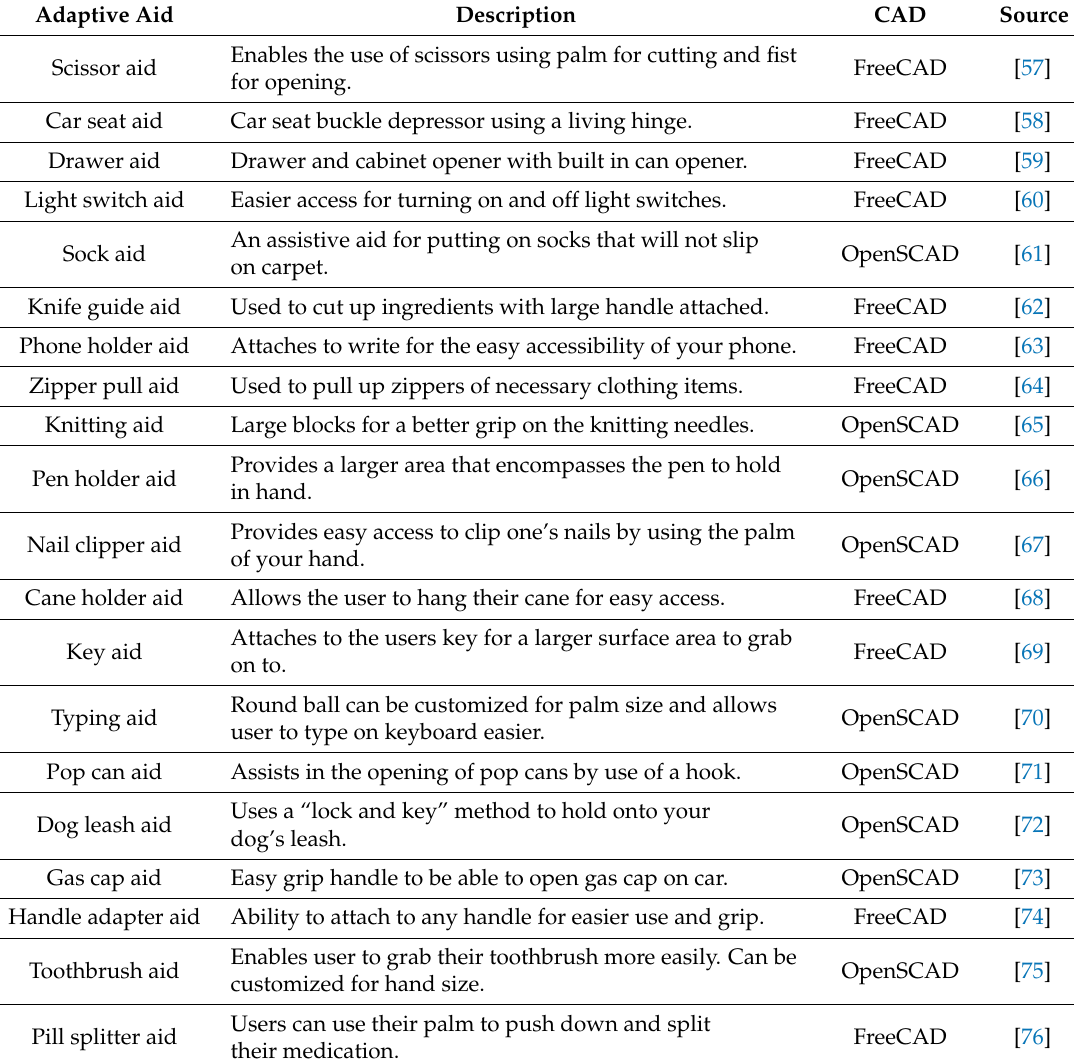
Table 1. Selected open-source 3-D printable adaptive aids for arthritis